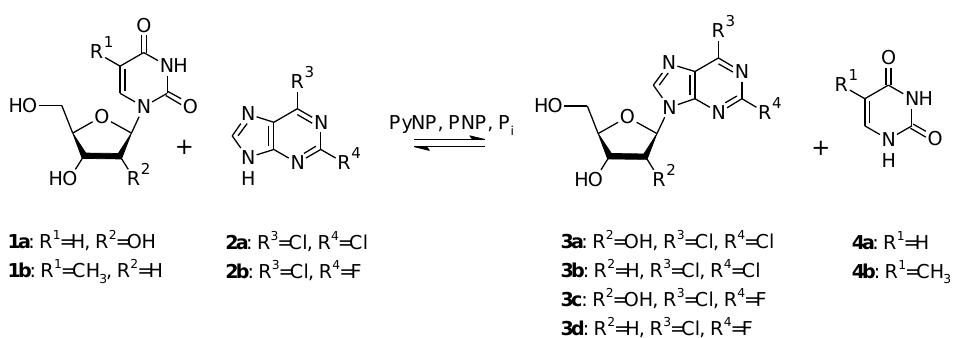
Table 1. Equilibrium state thermodynamic calculations were used to determine appropriate reaction conditions for the maximum conversion of 3 a – d